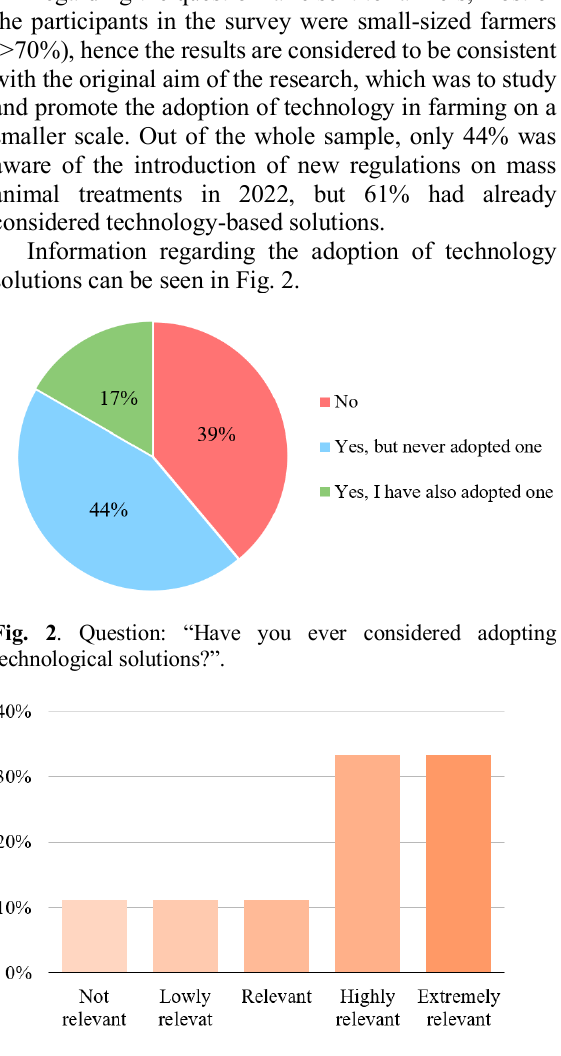
Fig. 3. Question: “How relevant is for you, together with the technical aspects, the economical safety of an investment of this sort?”.